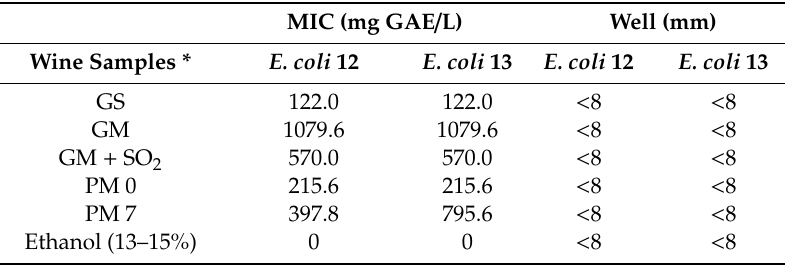
Table 2. Antimicrobial activity of wines ( n =